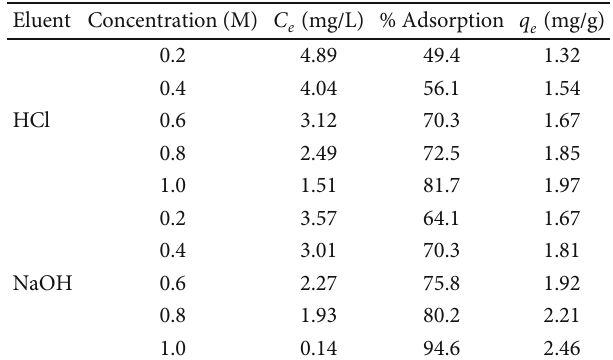
Table 13: Adsorption capacity and % adsorption by using di ff erent conc. of NaOH and HCl for ACMAS